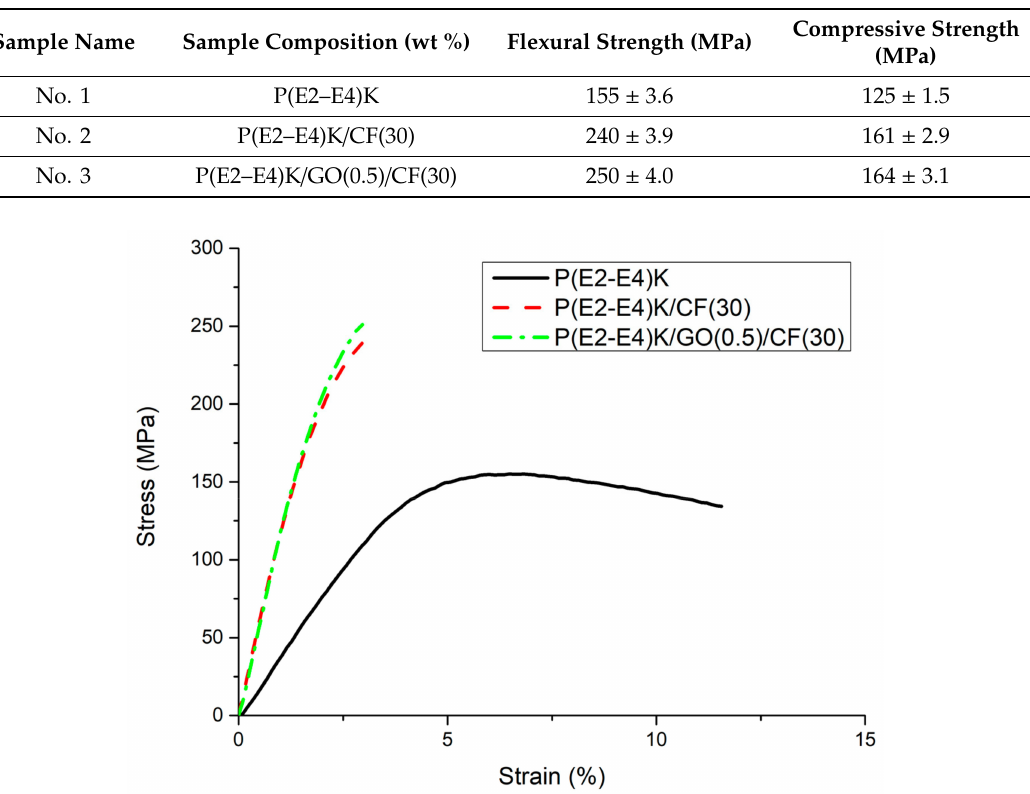
Table 3. Flexural and compressive strength test results of the P(E2–E4)K composites.